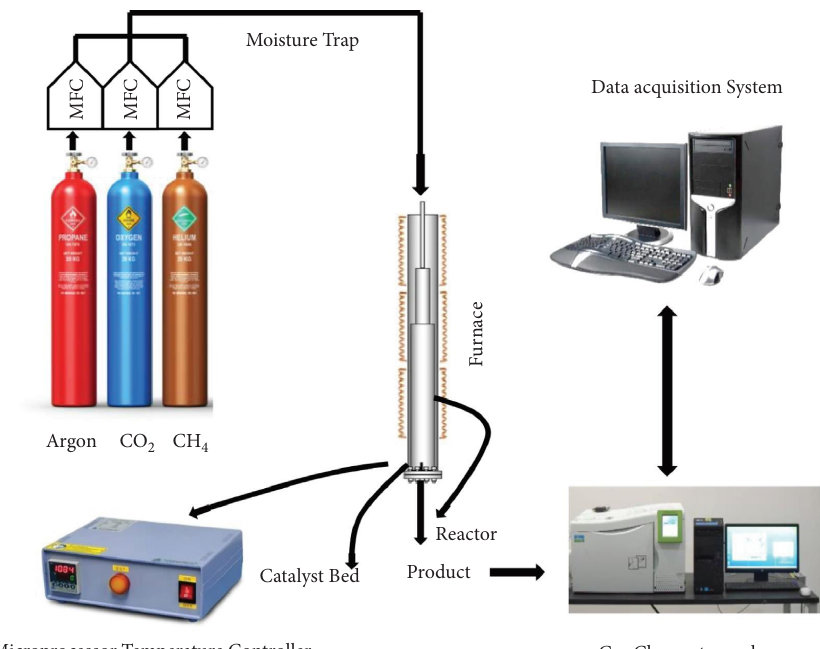
Figure 2: Schematic diagram of the reactant and products analysis.